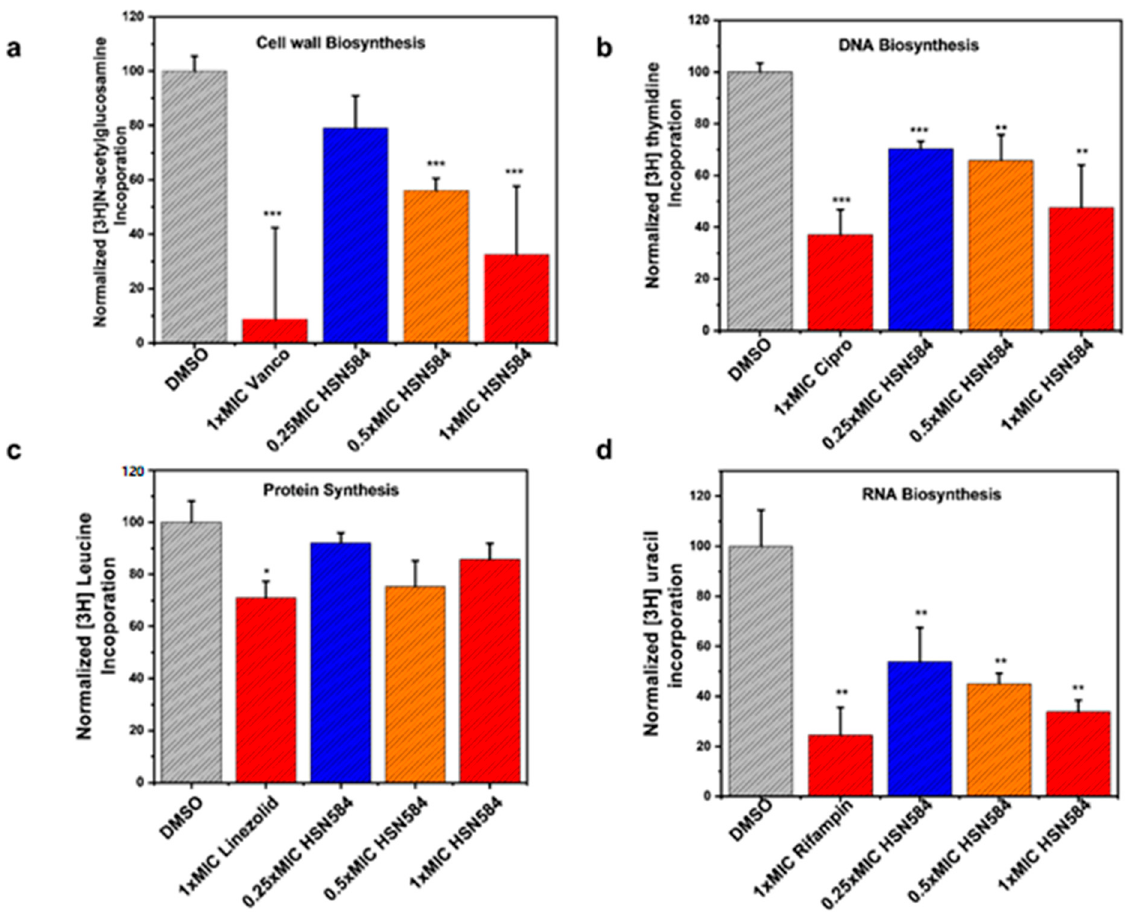
Figure 8. HSN584 effects on S. aureus ATCC 25923 macromolecule synthesis. ( a ) HSN584 effects on [ 3 H] N-acetylglucosamine incorporation into S. aureus cell wall. ( b ) HSN584 effects on [ 3 H] thymidine incorporation into S. aureus DNA. ( c ) HSN584 effects on [ 3 H] leucine incorporation into S. aureus protein. ( d ) HSN584 effects on [ 3 H] uridine incorporation into S. aureus RNA. Student’s t -test was used for statistical analysis. * p -value < 0.05, ** p -value < 0.01, *** p -value < 0.001.